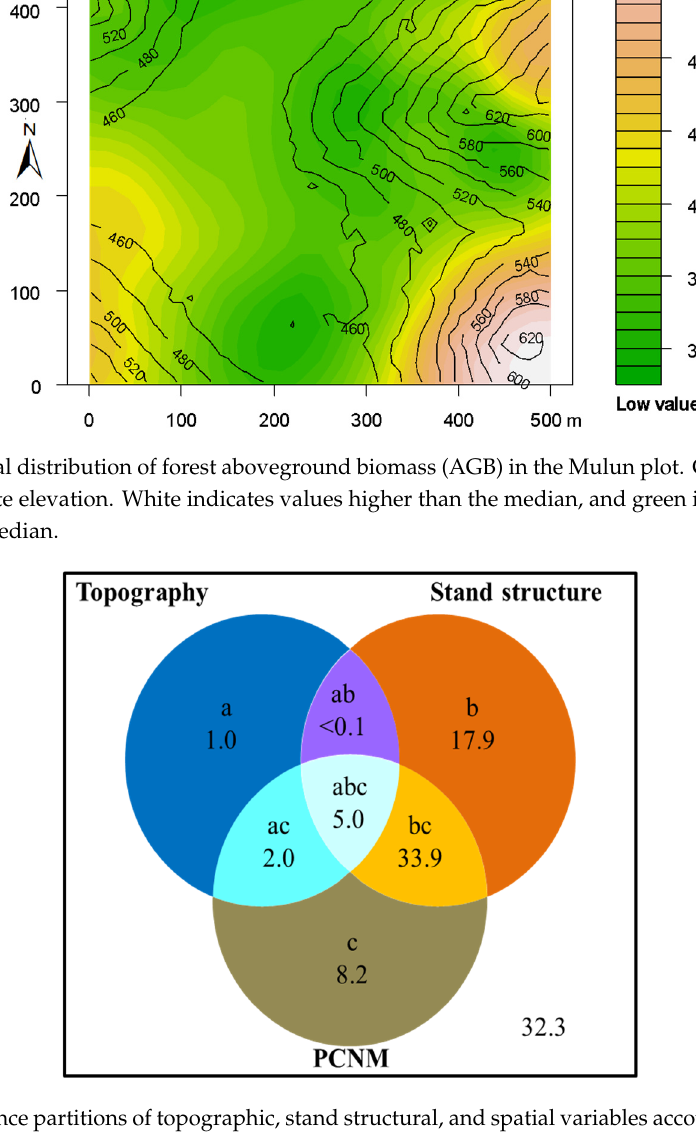
Figure 4. Variance partitions of topographic, stand structural, and spatial variables account for the AGB variation (%). The symbols a, b, c represent the independent effects of topography, stand structure, and selected spatial variables, respectively; ab is the interactive effect of topography and stand structure; ac, the interactive effect of topography and selected spatial variables; bc, the interactive effect of stand structure and selected spatial variables; and abc, the interactive effect of topography, stand structure and selected spatial variables.